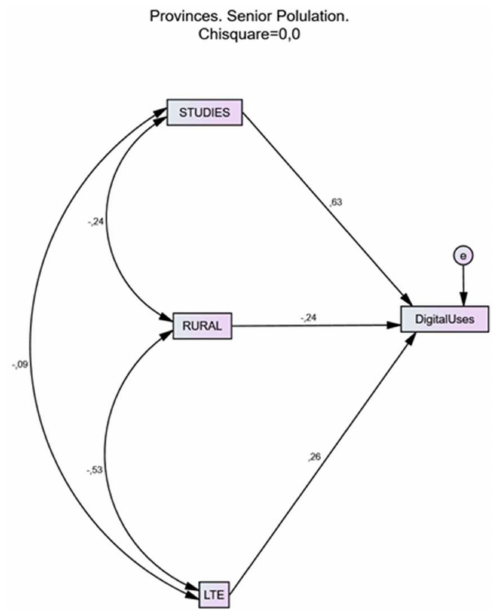
Figure 6. Differences between provinces. Senior population digital